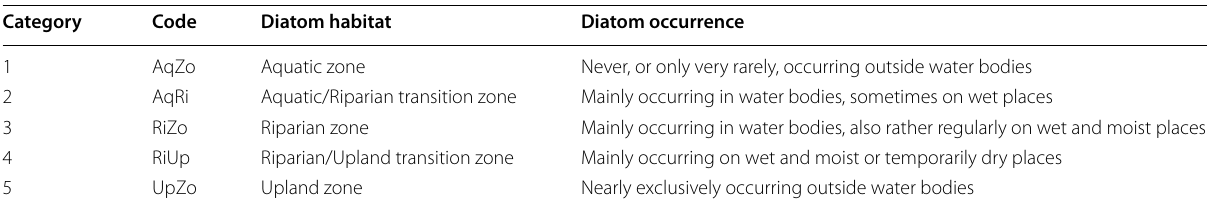
Table 1 Classification of the moisture indices